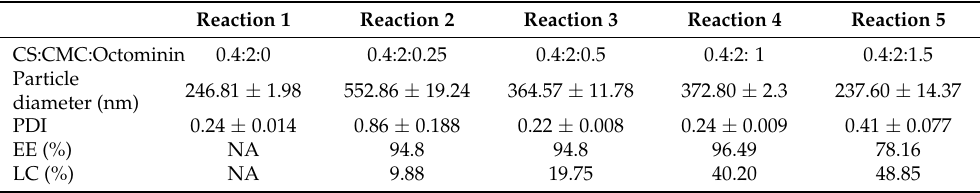
Polydispersity index—PDI, encapsulation efficiency—EE, and loading